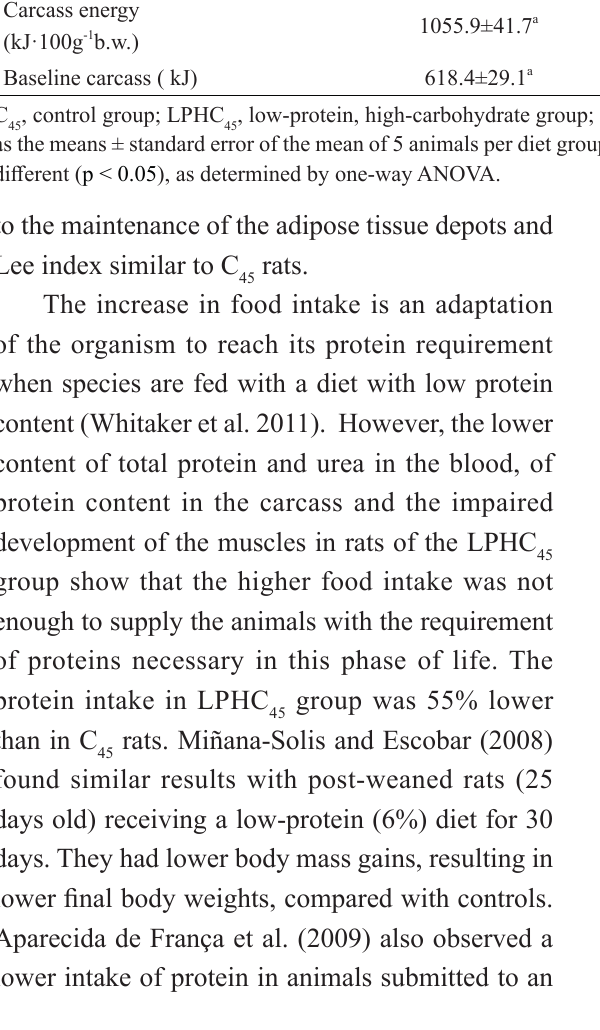
Carcass composition